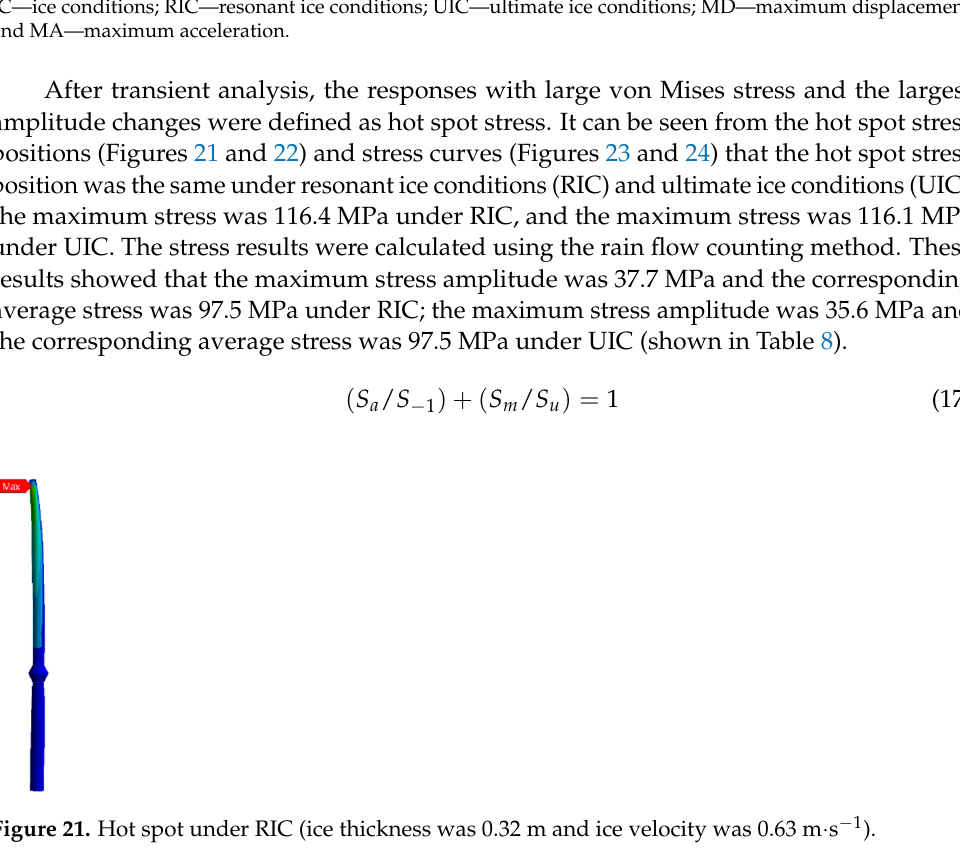
Figure 21. Hot spot under RIC (ice thickness was 0.32 m and ice velocity was 0.63 m · s − 1 ).